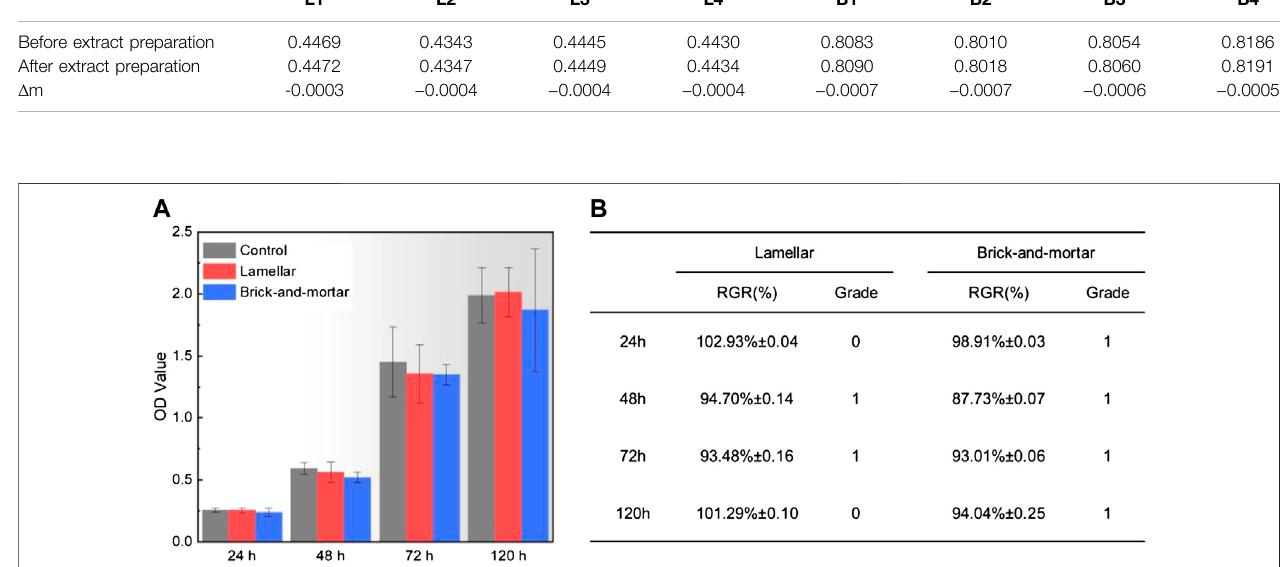
FIGURE2 |(A) Optical density ofHPDLF cells inextraction medium ofexperimental materials measured byCCK8 test and (B) relativegrowth rate and cytotoxicity level at different detection